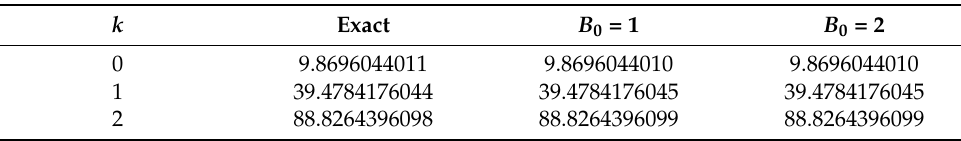
Table 4. Comparing the eigenvalues for Example 4 with the present BSFM using B 0 = 1 and B 0 = 2 to the exact ones. k Exact B 0 = 1 B 0 = 2